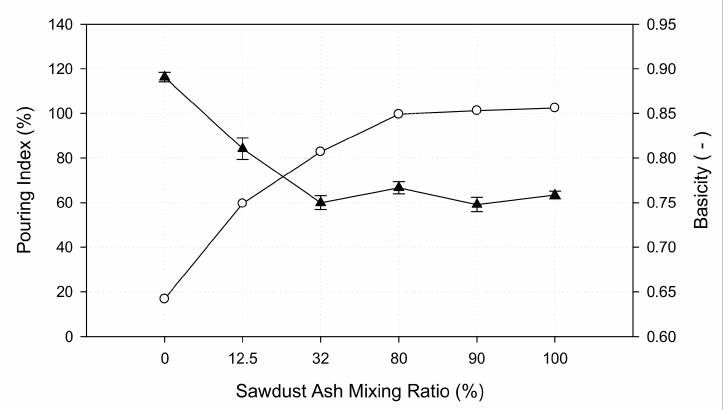
Figure 10. Pouring index at various sawdust mixing ratios ( (cid:78) : Pouring index,